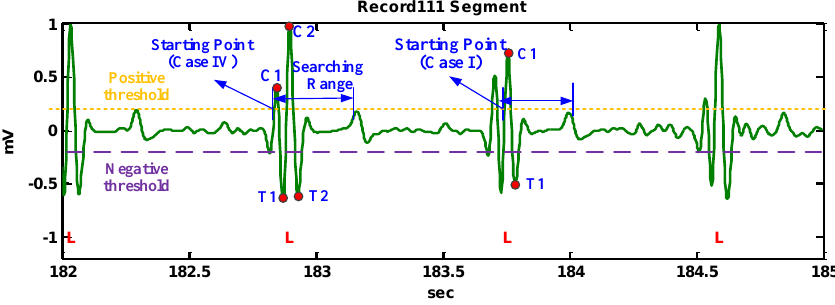
Figure 10. The demonstration of QRS fiducial point detection for the Record 111 segment.